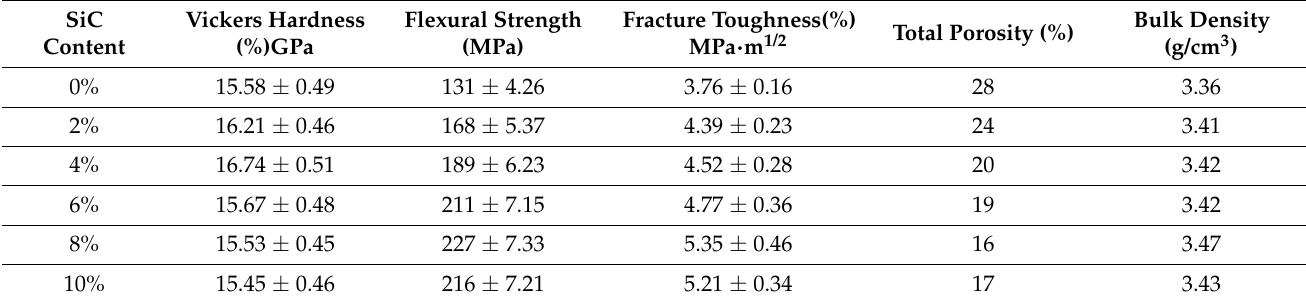
Table 2. Mechanical properties of ceramic samples sintered at 1600 ◦